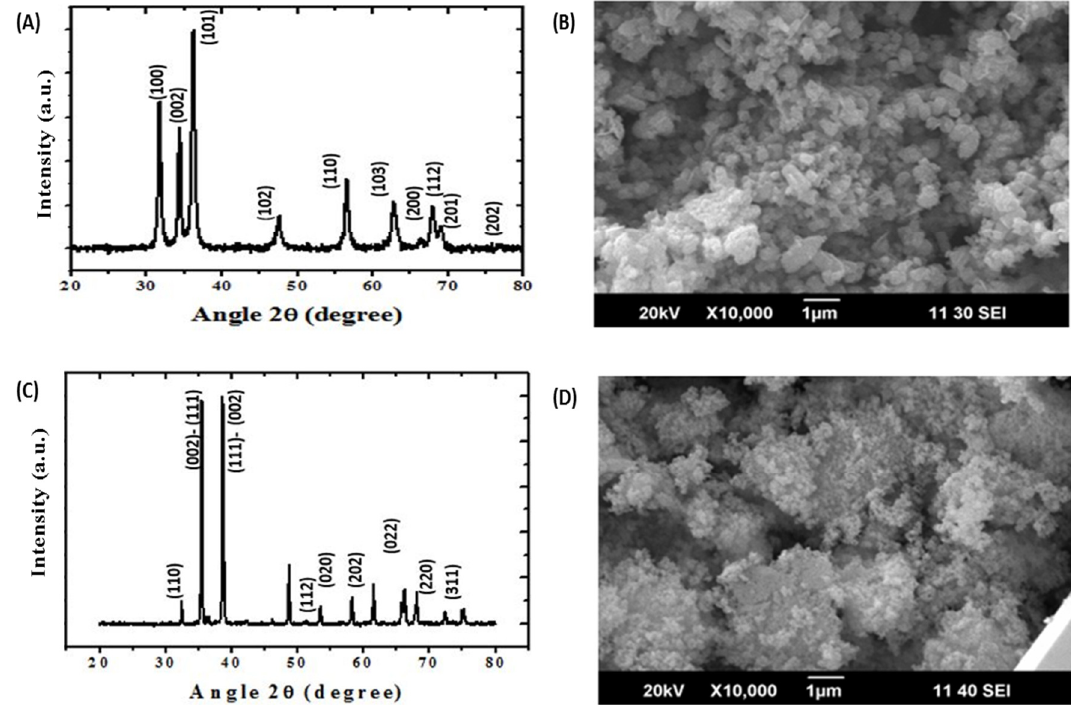
Figure 1. ( A ) X-ray diffractogram (XRD) of ZnO engineered nanoparticles (ENPs), ( B ) scanning micrograph (SEM) of ZnO ENPs, ( C ) X-ray di ff ractogram (XRD) of CuO ENPs, and ( D ) scanning electron micrograph (SEM) of ZnO ENPs, ( C ) X-ray diffractogram (XRD) of CuO ENPs, and ( D ) electron micrograph (SEM) of CuO scanning electron micrograph (SEM) of CuO ENPs.